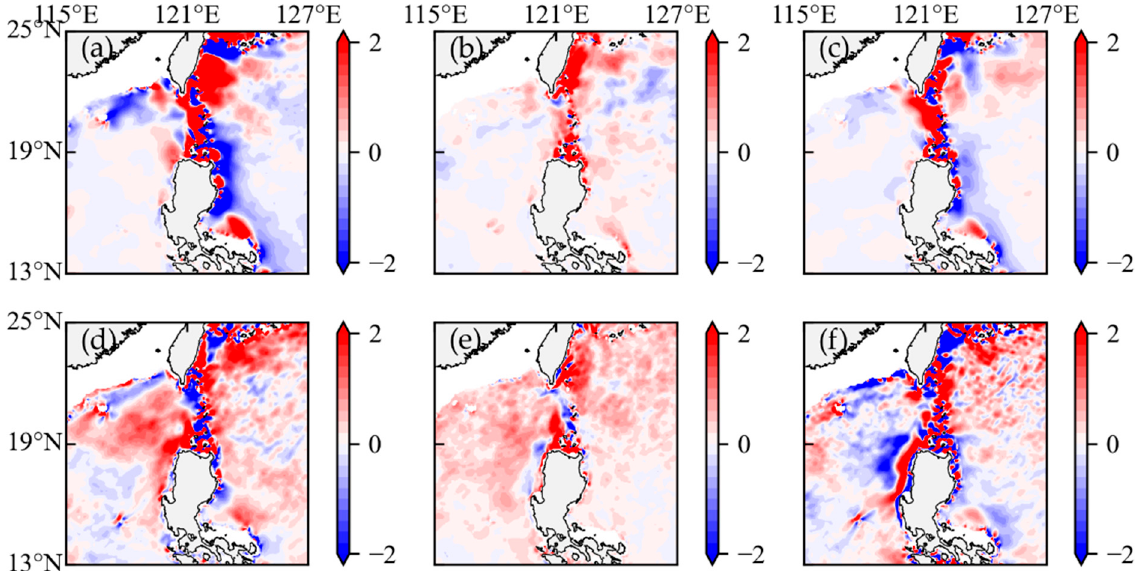
Figure 9. Temporally (1996–2015) and vertically (upper 266 m) averaged canonical transfers (10 − 5 Wm − 3 ). ( a ) Γ K 0 2 ; ( b ) Γ K 1 2 ; ( c ) Γ K 0 1 ; ( d ) Γ A 0 2 ; ( e ) Γ A 1 2 ; ( f ) Γ A 0 1 .